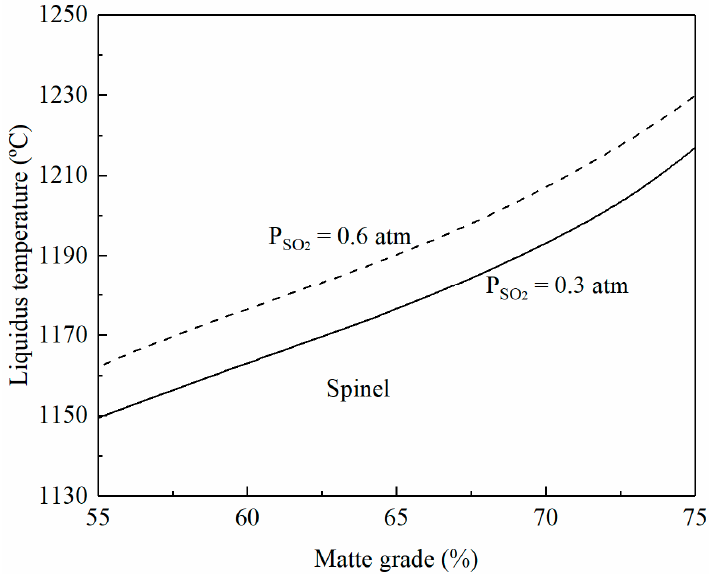
Figure 2. Effects of matte grade and SO 2 partial pressure on liquidus temperature of smelting slag, predicted by FactSage 8.2.